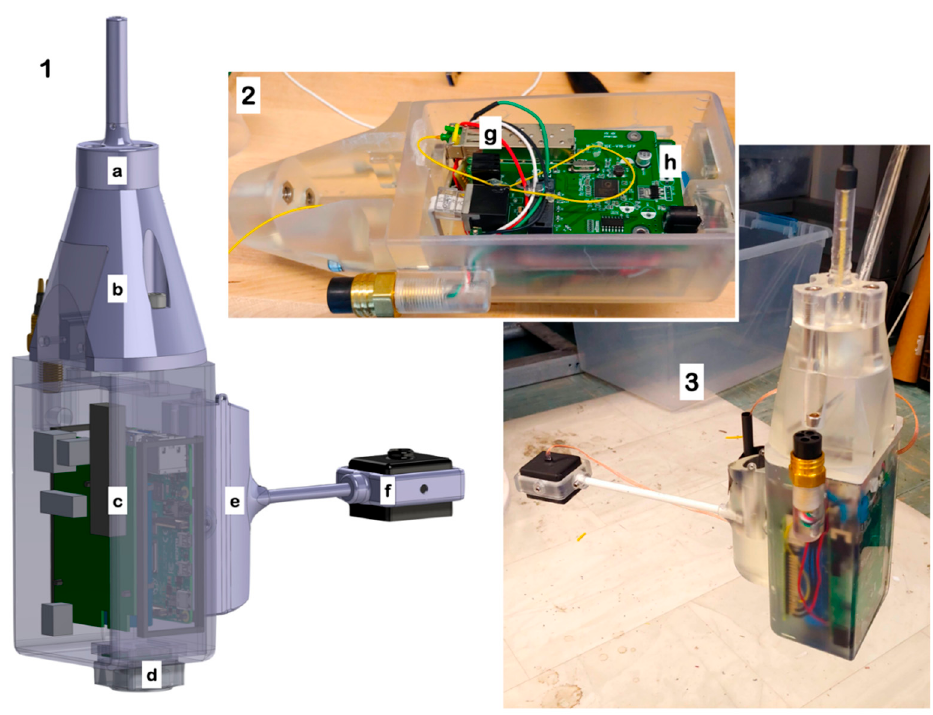
Figure 2. Data payload system (DPS) used with the FOReelS system. ( 1 ) CAD model of DPS with